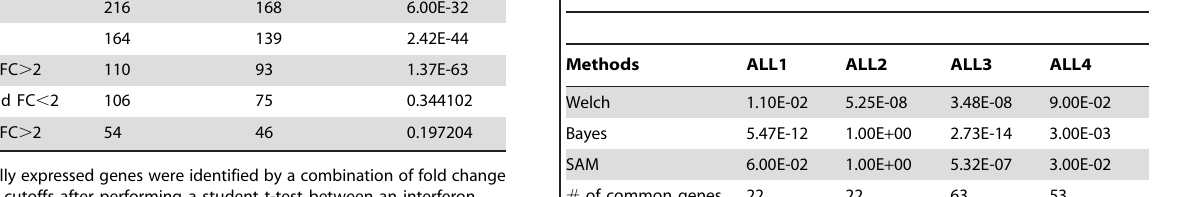
these DEGs were very small (Table 5). In contrast, only 22 genes out of the top 100 DEGs produced by each method were common to either the ALL1 or ALL2 dataset. Interestingly, for each Table 5. LPvs for gene sets identified by different feature selection methods on four different microarray experiments (ALL1, ALL2, ALL3, and ALL4; see text for